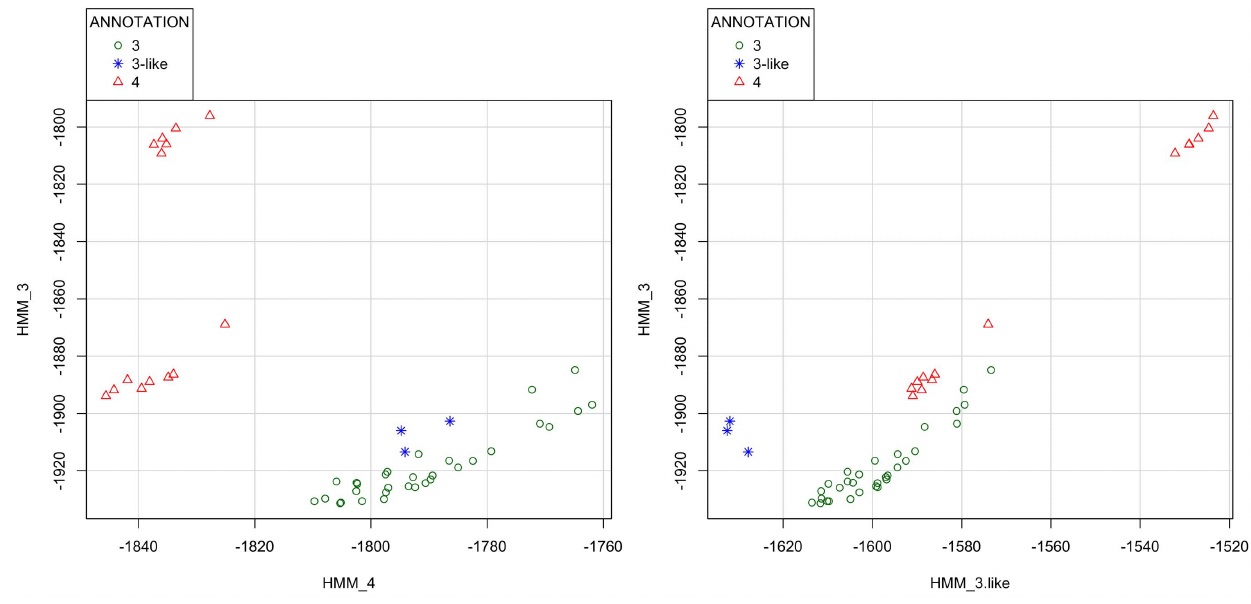
Figure 4. Two-dimensional scatterplots of profile HMM negative log-likelihood scores for H5N1 hemagglutinins in clades 3 (green circles) and 4 (red triangles) along with those in a clade 3-like group (blue stars). (A) Plot shows scores for the clade 3 -specific pHMM (Y-axis) versus scores for the clade 4 -specific pHMM (X-axis). (B) As in A, but with the X-axis containing scores for the 3-like pHMM instead. Smaller (more negative) numbers are considered better fits for that clade or group.